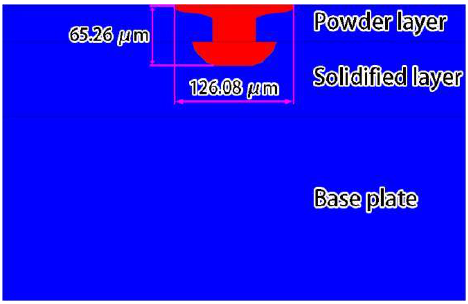
Figure 10. Simulation result of the transverse section of the solidified track.